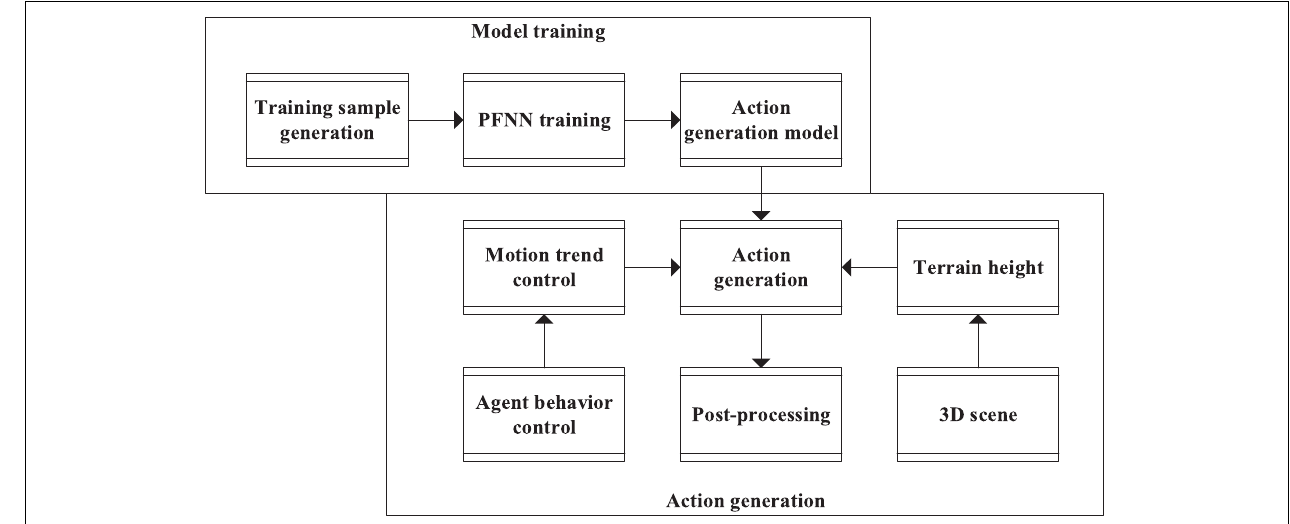
FIGURE 9 | Agent action generation scheme based on the Phase Functioned Neural Network